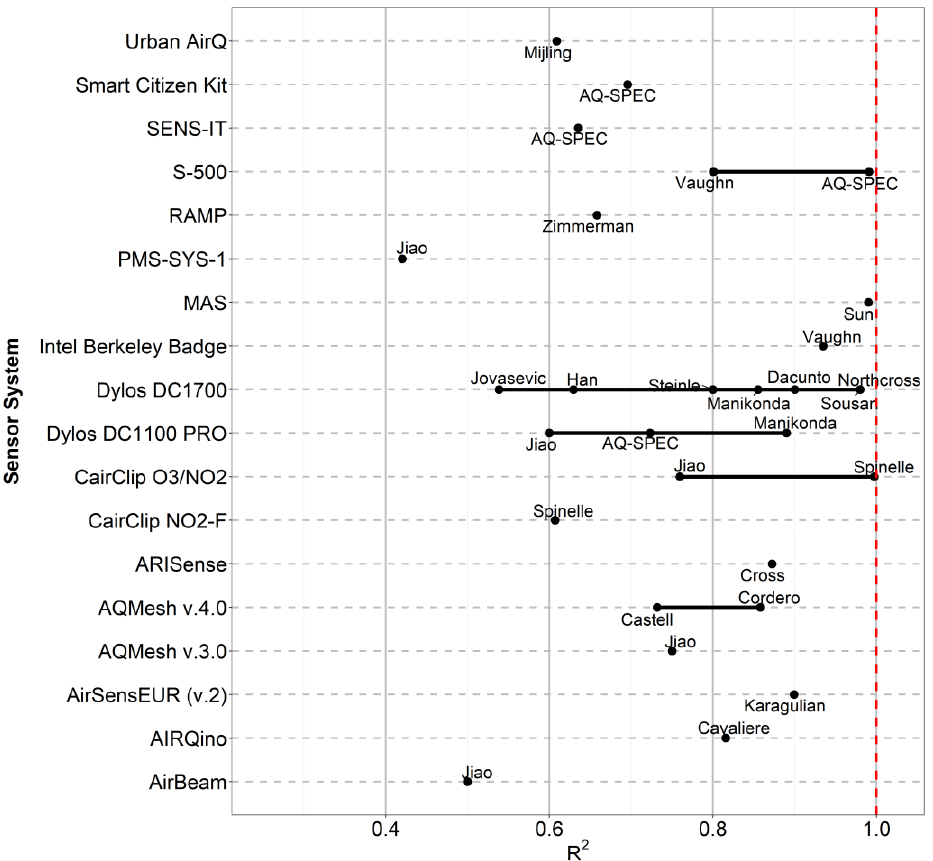
Figure 3. Mean R 2 found for LCS reporting calibration against reference measurements for all used